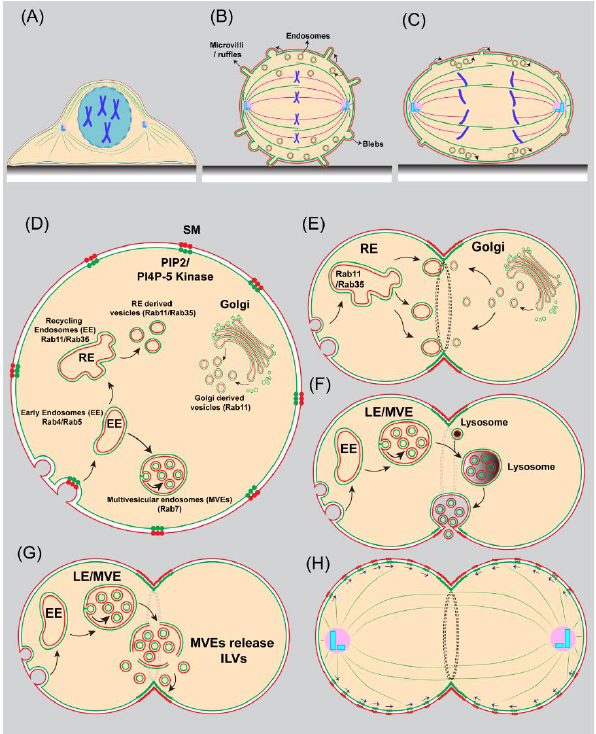
Figure 4. Mechanisms for membrane traffic and lipid polarization during cytokinesis. ( A – C ) Regu- lation of plasma membrane area in a dividing mammalian cell. ( A ) At the interphase, cultured, ad- herent mammalian cells appear flat; ( B ) at the onset of mitosis, cells lose their attachment to the substrate and begin to round up and reduce their surface area. To accommodate this change in sur- face area, the plasma membrane folds into blebs, microvilli, and ruffles and becomes endocytosed. ( C ) During anaphase, cell surface area increases, which correlates with the fusion of recycling endo- somes with the plasma membrane and the expansion of membrane projections. ( D ) An eukaryotic cell in prophase showing endomembrane compartments, including early endosomes (EE), recycling endosomes (RE), multivesicular endosomes (MVEs), the Golgi apparatus, and vesicles derived from these compartments. The plasma membrane bilayer is shown with an outer leaflet (red) and an inner leaflet (green). Circular dots on the plasma membrane correspond to lipid domains, including sphingomyelin-rich domains (red dots) and Phosphatidylinositol-4, 5-bisphosphate (PIP2) and its biosynthetic enzyme PI(4)P 5-kinase (green dots). ( E ) A diagram depicting membrane trafficking from recycling endosomes and the Golgi apparatus to the cleavage furrow. ( F ) Cartoon showing membrane addition via lysosome exocytosis at the cleavage furrow in mammalian cells. Late endo- somes (LE), Multivesicular endosomes (MVE). ( G ) Schematic representation of membrane traffick- ing via multivesicular endosomes that release their intraluminal vesicles in the cytosol near cleavage furrow in Drosophila spermatocytes. ( H ) Illustration of lateral movement of transbilayer-coupled lipid domains towards the cleavage furrow via a cortical flow mechanism.